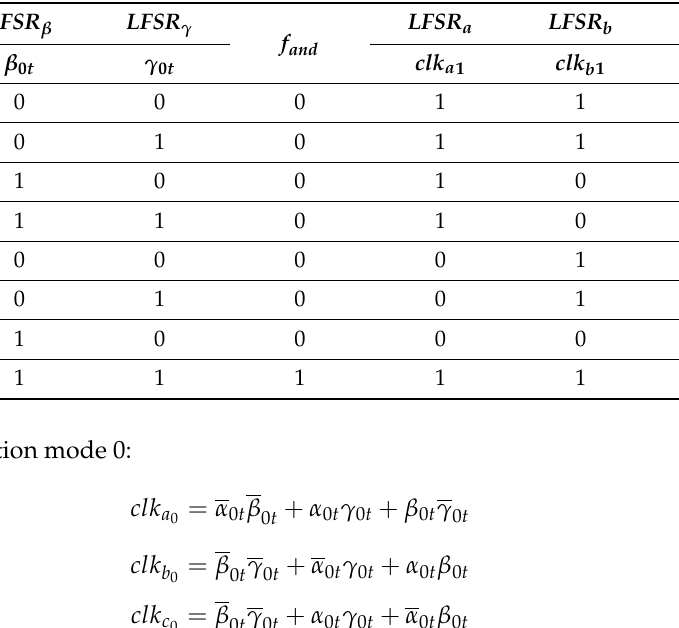
Table 3. Clocking condition under m 0 =